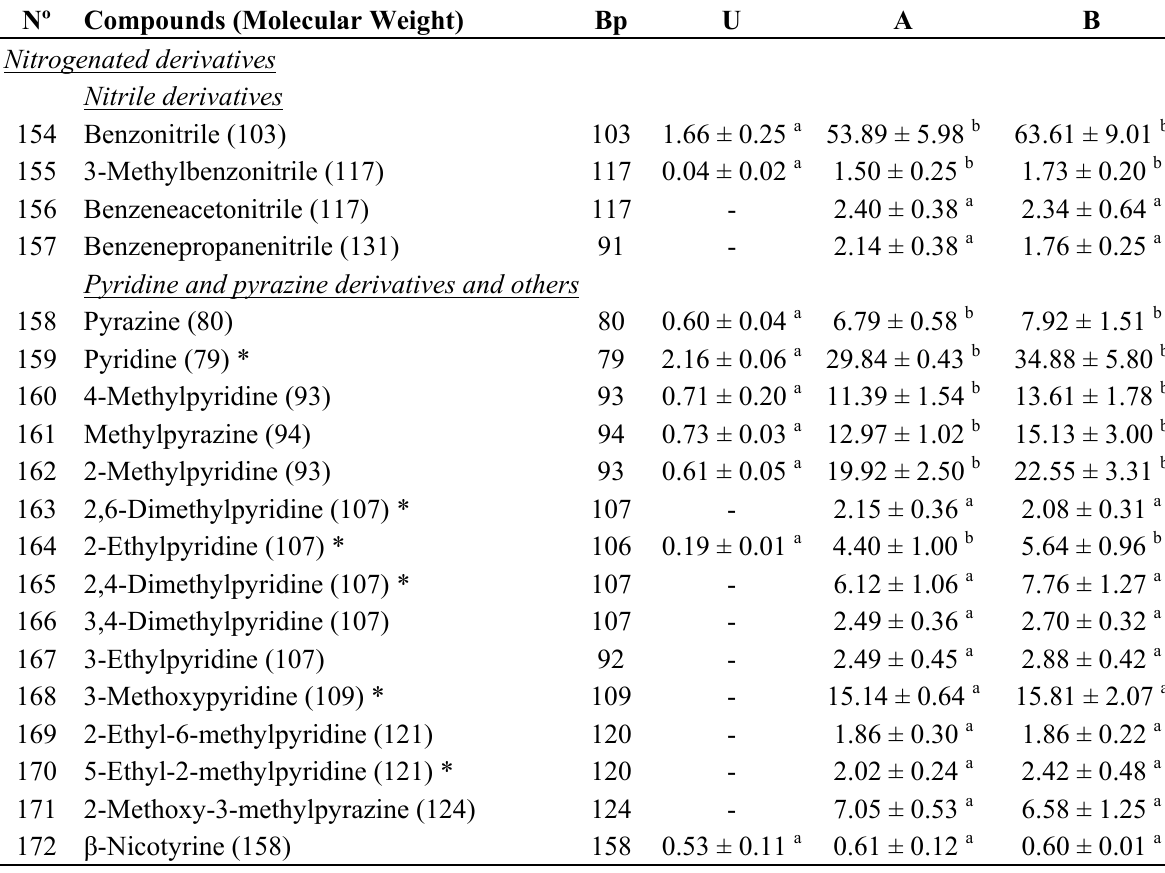
Table 4. Nitrogenated derivatives detected in the headspace of the exterior region of unsmoked (U) and smoked (A and B) Herreño cheeses studied, together with their molecular weight, the base peak of their mass spectra (Bp), their abundance, expressed as average area counts of their mass spectra base peak divided by 10 5 , and standard deviation a